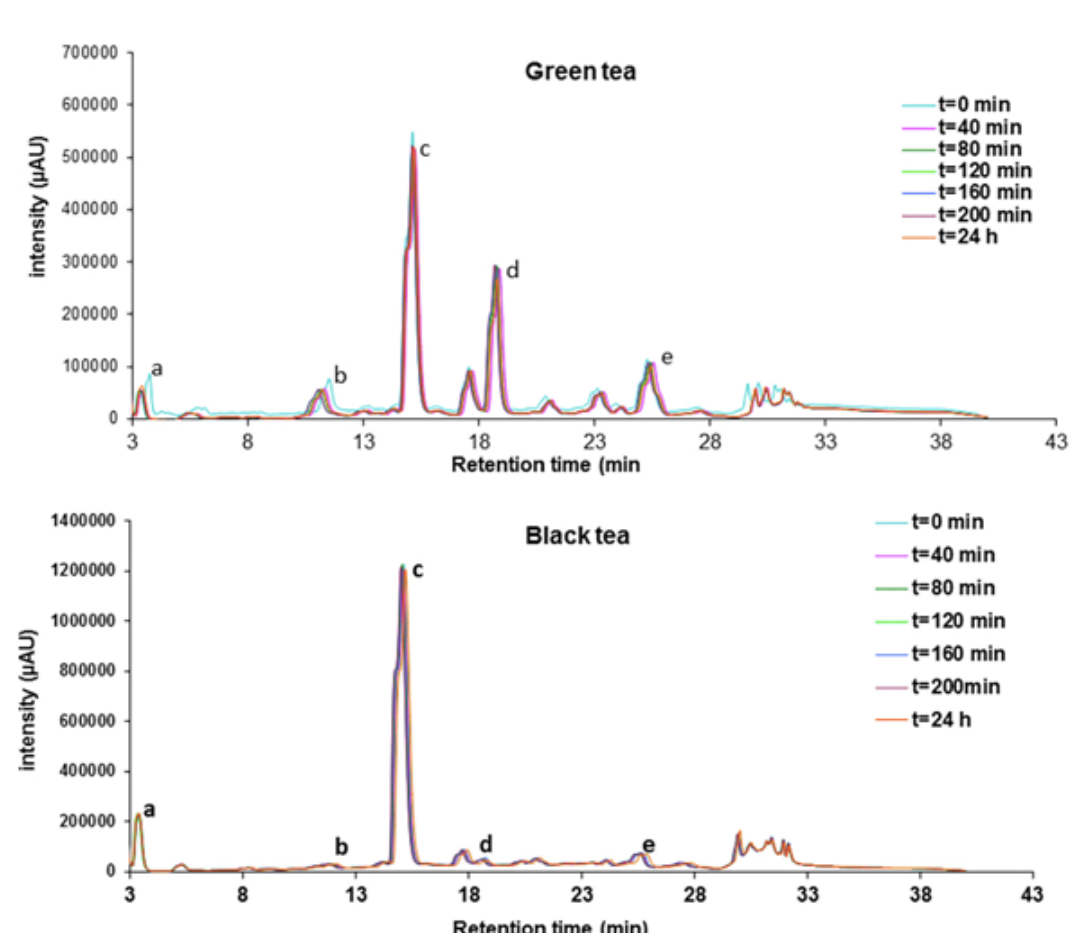
FIGURE 1 - HPLC chromatograms of green and black tea samples over a 24-hour period. ( a = gallic acid; b = catechin; c = caffeine; d = epigallocatechin; e = epicatechin). TABLE III - Total phenolic content (TPC) and radical scavenging activity (RSA) of green and black tea, prepared with different water